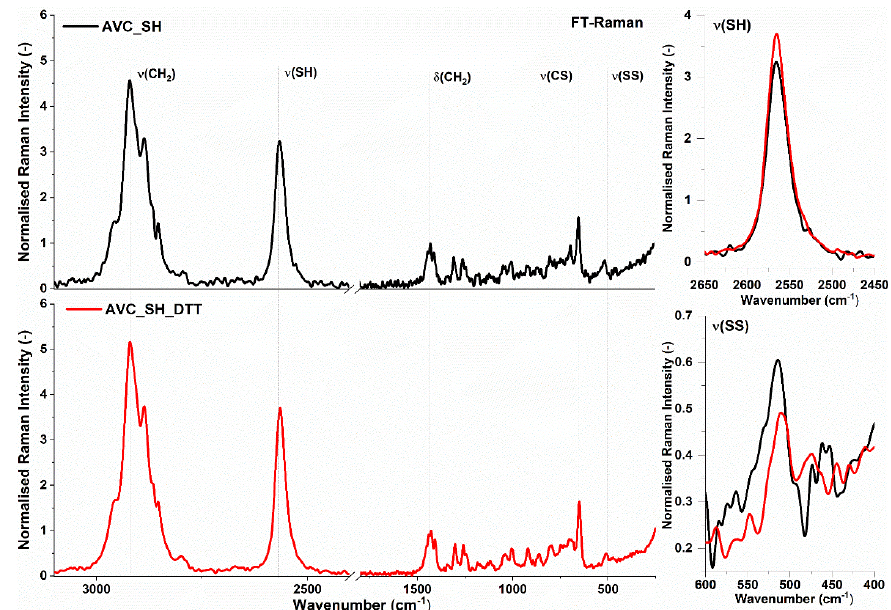
Figure 4. FT-Raman spectra of the ammonium acryloyldimethyltaurate/vinylpyrrolidone co-polymer (AVC) after mercaptosilanization ( upper ) and incubation with dithiothreitol (DTT) at 37 °C (98 °F) for 1 h ( bottom ) with spectra in the SH and SS stretching vibrations ranges ( right ).